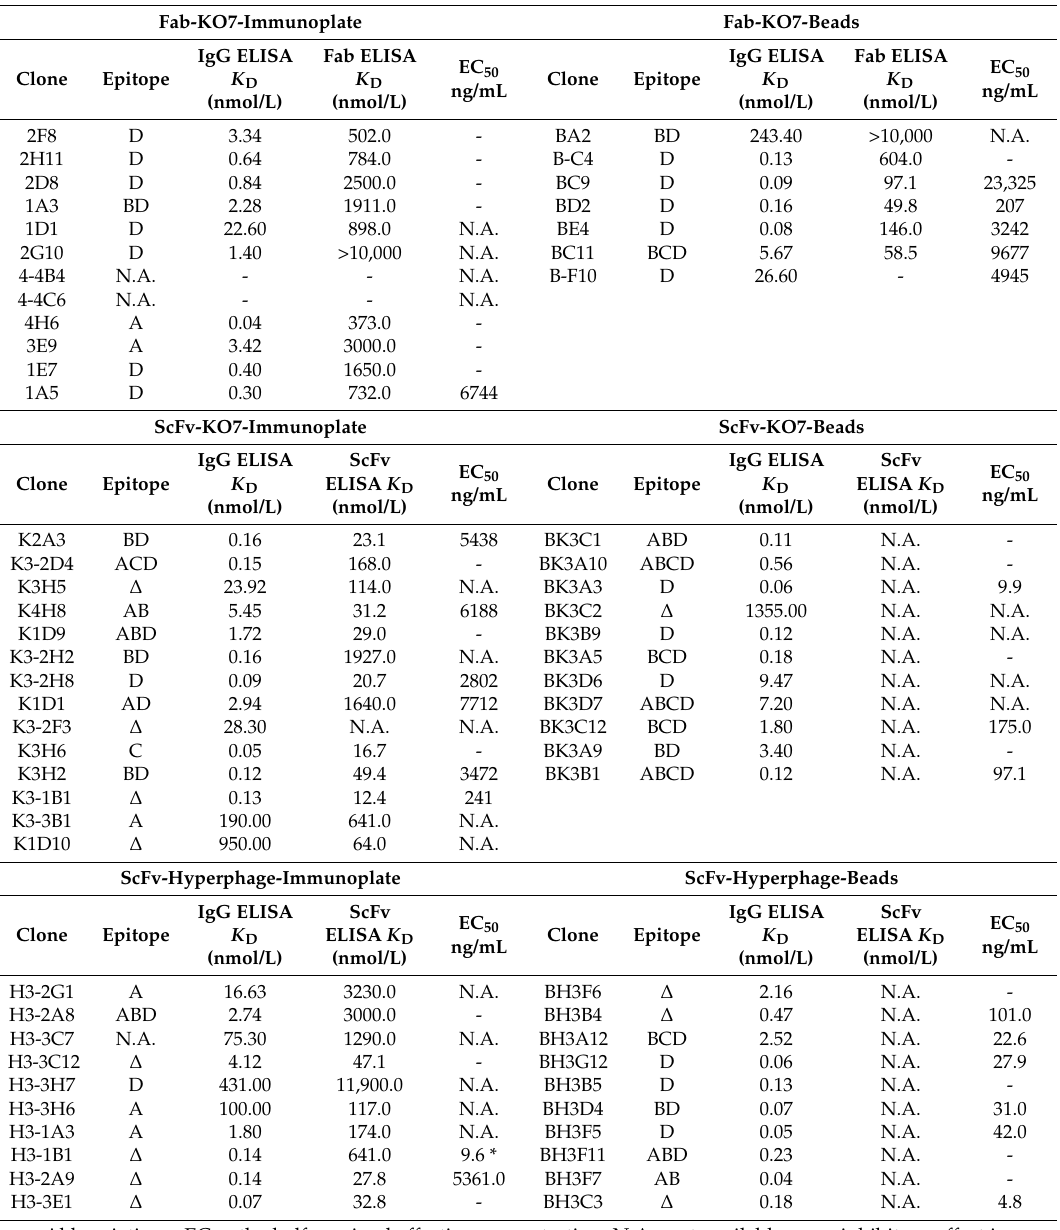
Table 1. Binding affinity, epitope and anti-proliferation activity of isolated clones.